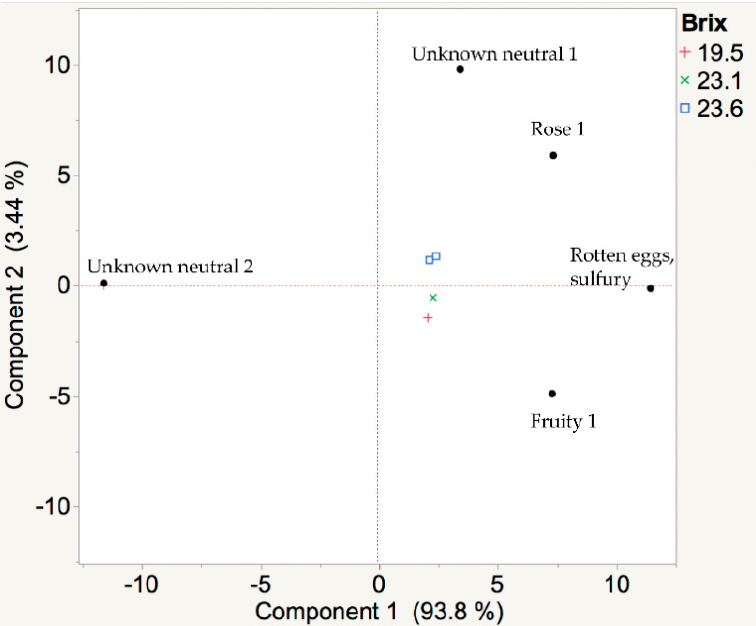
Figure 3. A principal components analysis (PCA) biplot of volatiles from the aroma extract dilution analysis of Frontenac gris wines made from berries harvested at three different ripening stages. Wines were made from Frontenac gris cold-hardy grapes harvested at 19.5, 23.1, and 23.6 °Brix. The juice was adjusted to 24 °Brix prior to fermentation. Wine headspace samples were collected by solid-phase microextraction (SPME) and analyzed with gas chromatography-mass spectrometry-olfactometry (GC-MS-O). Aroma descriptors were recorded by a trained human panelist. A shift of the aroma profile from “fruity 1”to “rotten eggs, sulfury” to “rose 1” was observed. Over 98% of the variation in harvest time is correlated with key odor-active compounds.